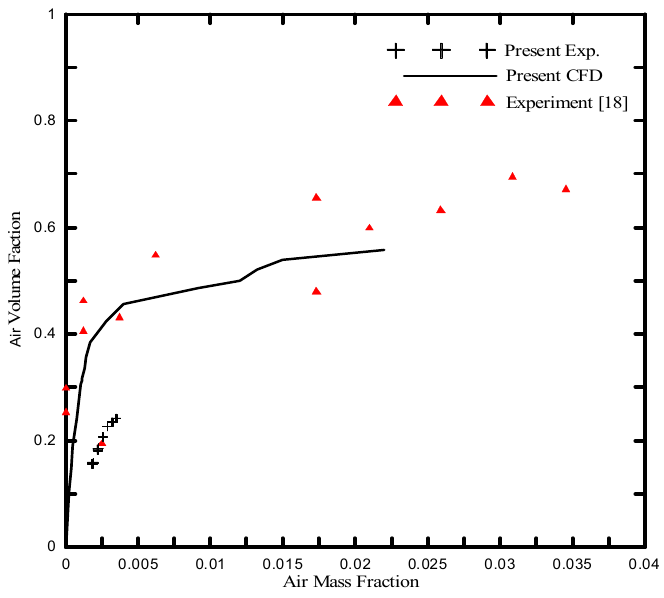
Figure 4. Comparison of the CFD results with those of the present experimental ones and reported in [18].